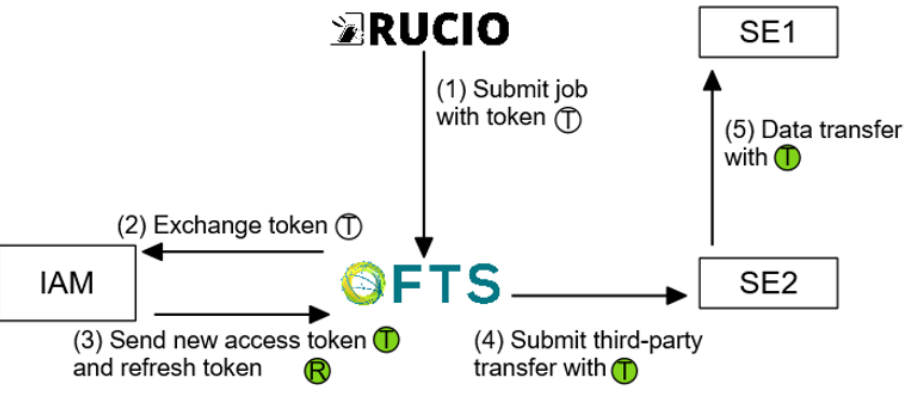
Fig. 3. The token workflow in the WLCG scenario, taking Rucio as an example